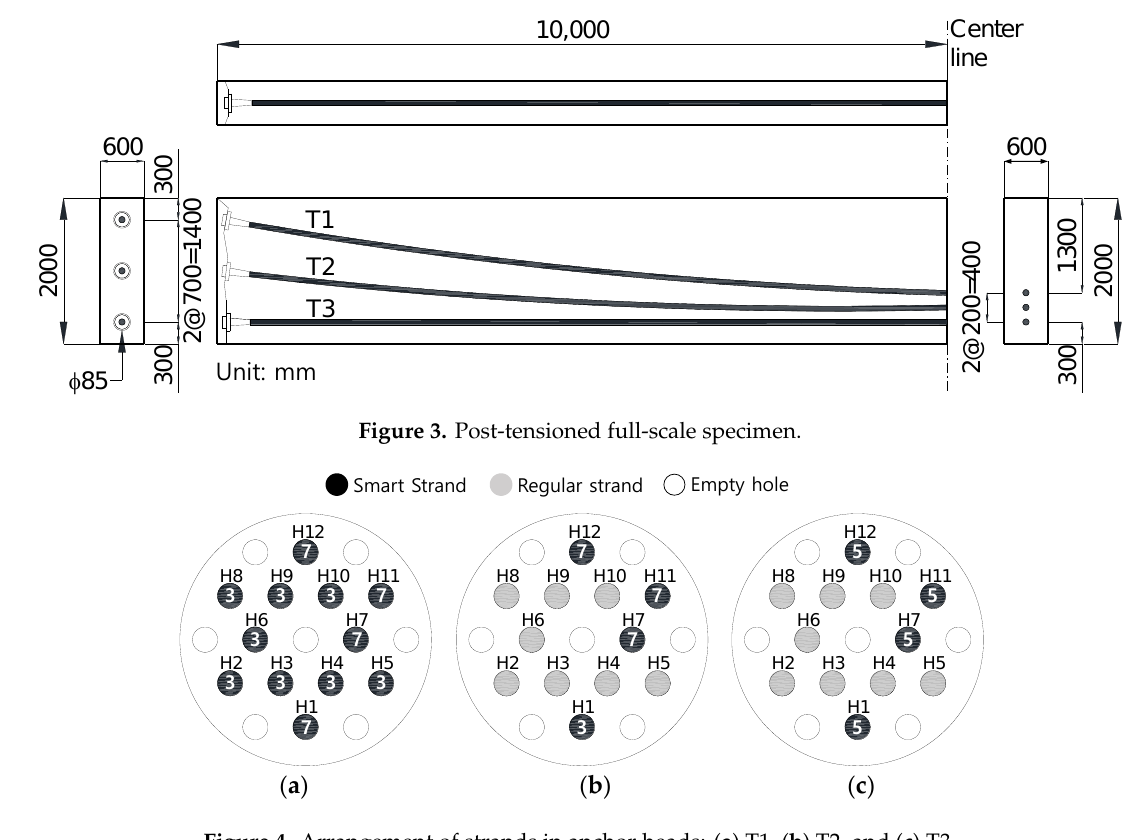
Figure 4. Arrangement of strands in anchor heads: ( a ) T1, ( b ) T2, and ( c ) T3.